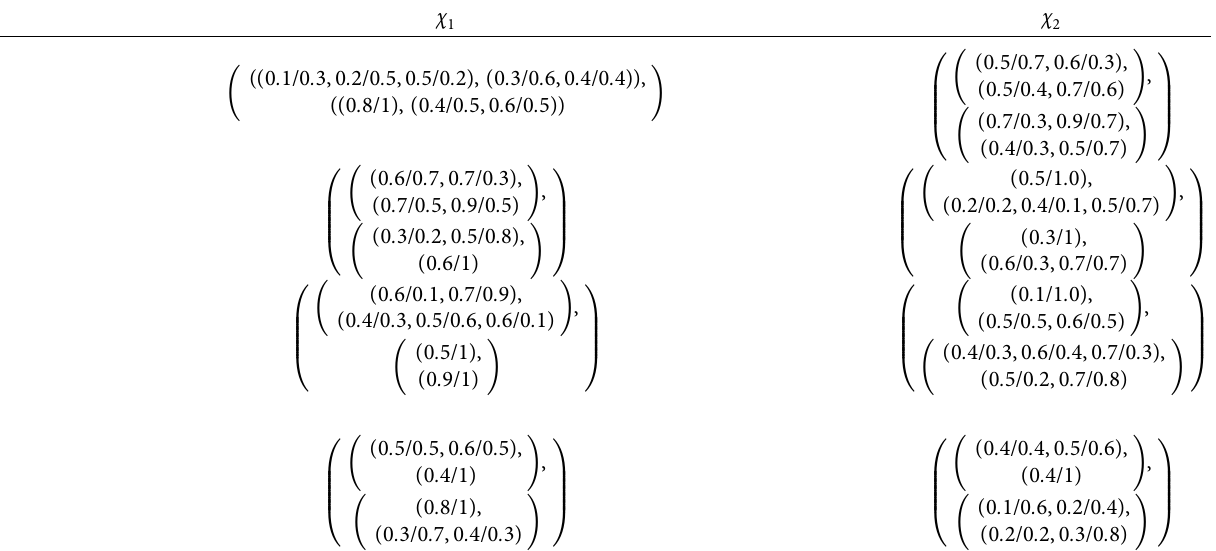
Table 9: Updated expert information.